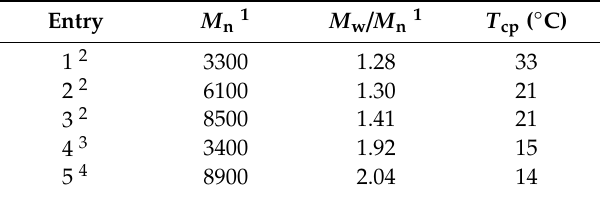
Table 2. Thermoresponsive behavior of aqueous solutions poly(DEGV- alt -EtMI). Entry